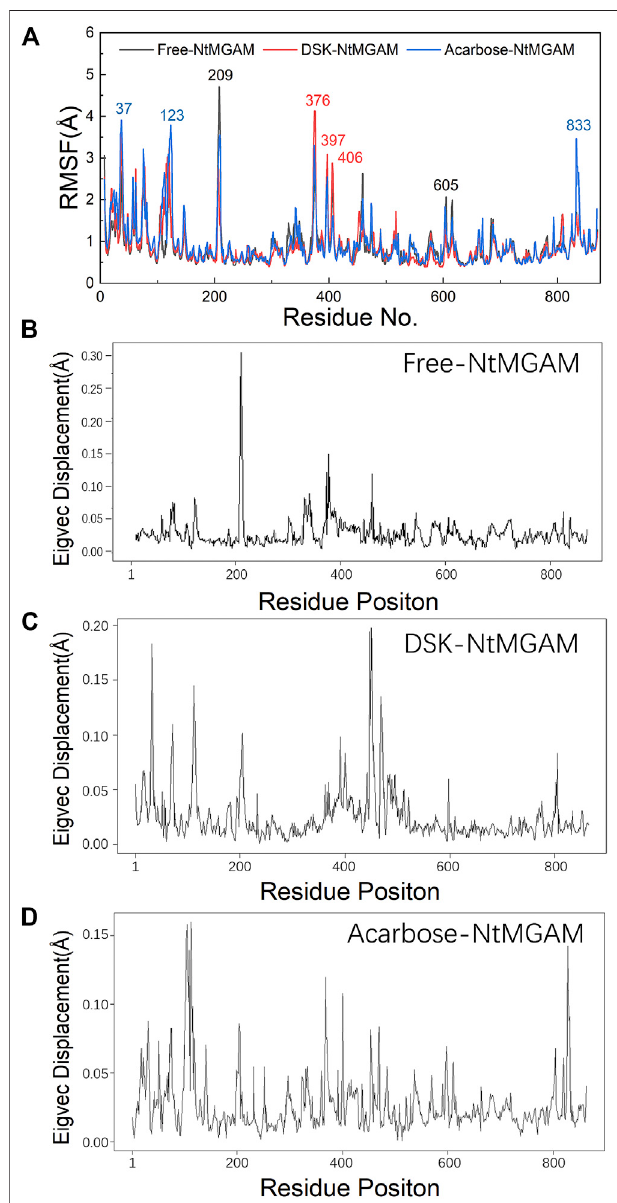
FIGURE 4 | (A) Average atom positional root-mean-square fl uctuations (RMSF) of the backbone atomsper residue for the inhibitors bound NtMGAM. (B – D) The eigenvector components for atomic displacement along the fi rst eigenvectors for MD-generated ensembles of free-NtMGAM, DSK- NtMGAM, and acarbose-NtMGAM,